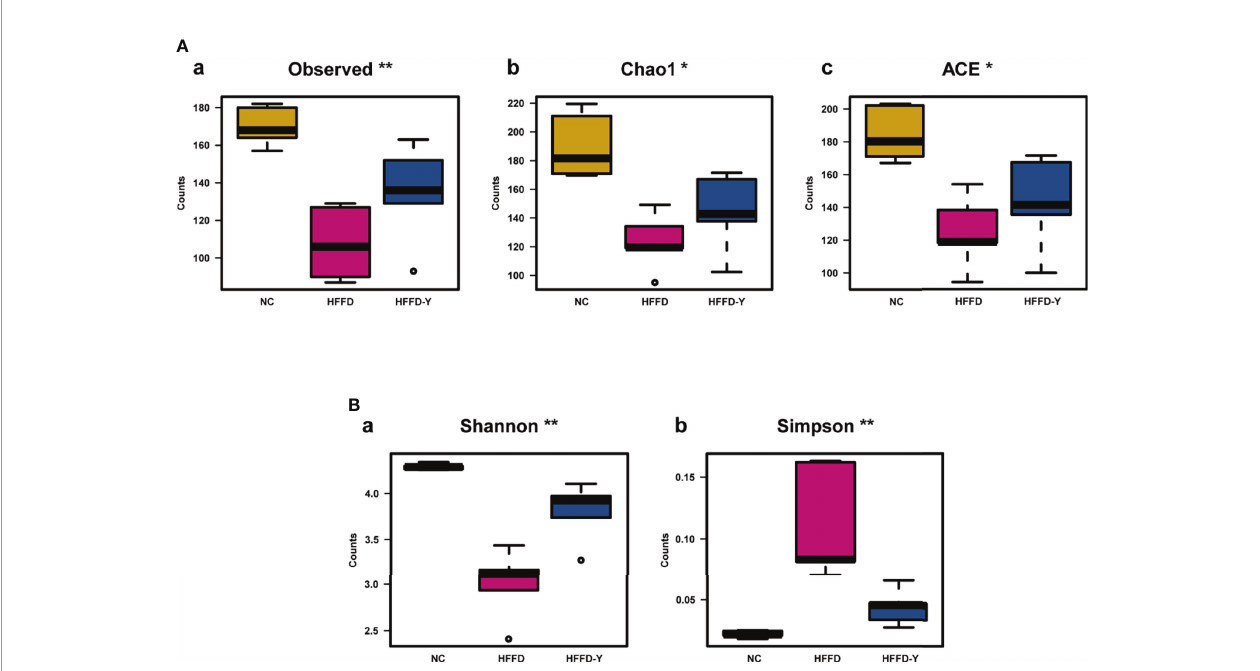
FIGURE 5 | Results of Alpha Diversity analysis. (A) Results of the index, re fl ecting the richness of the gut microbiota. (B) Results of the index, re fl ecting the diversity of the gut microbiota. (* p <0.05 vs HFFD, ** p <0.01 vs